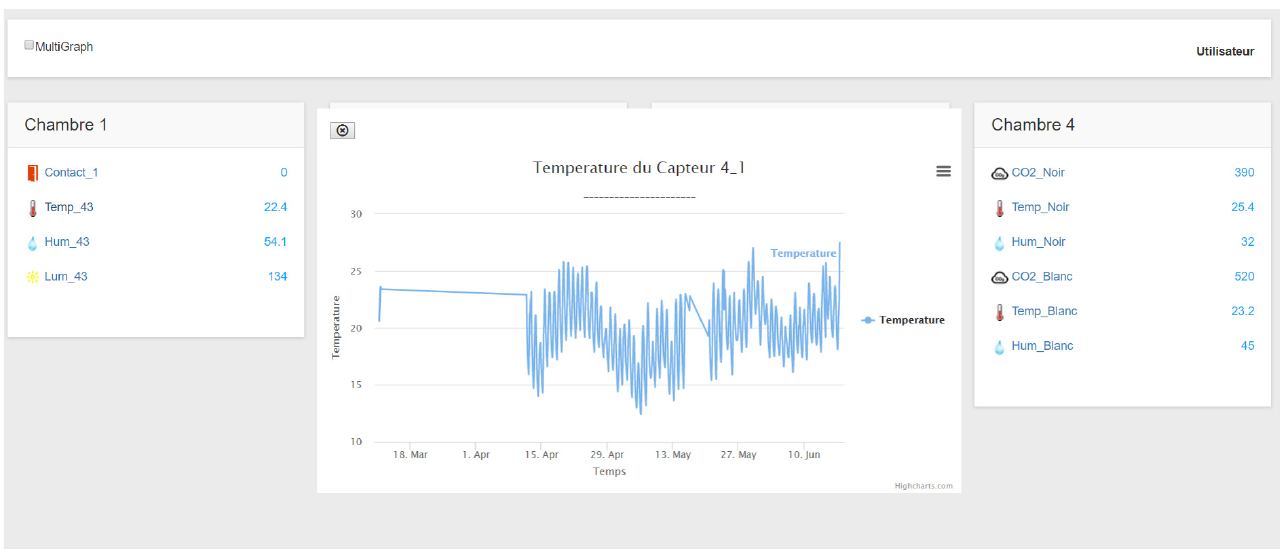
Figure 16. Occupant interface displaying temperature Figure 16. XXX.